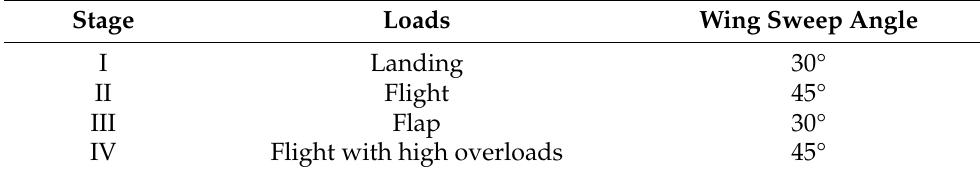
Table 1. Configurations of aircraft for Full-Scale Fatigue Test.